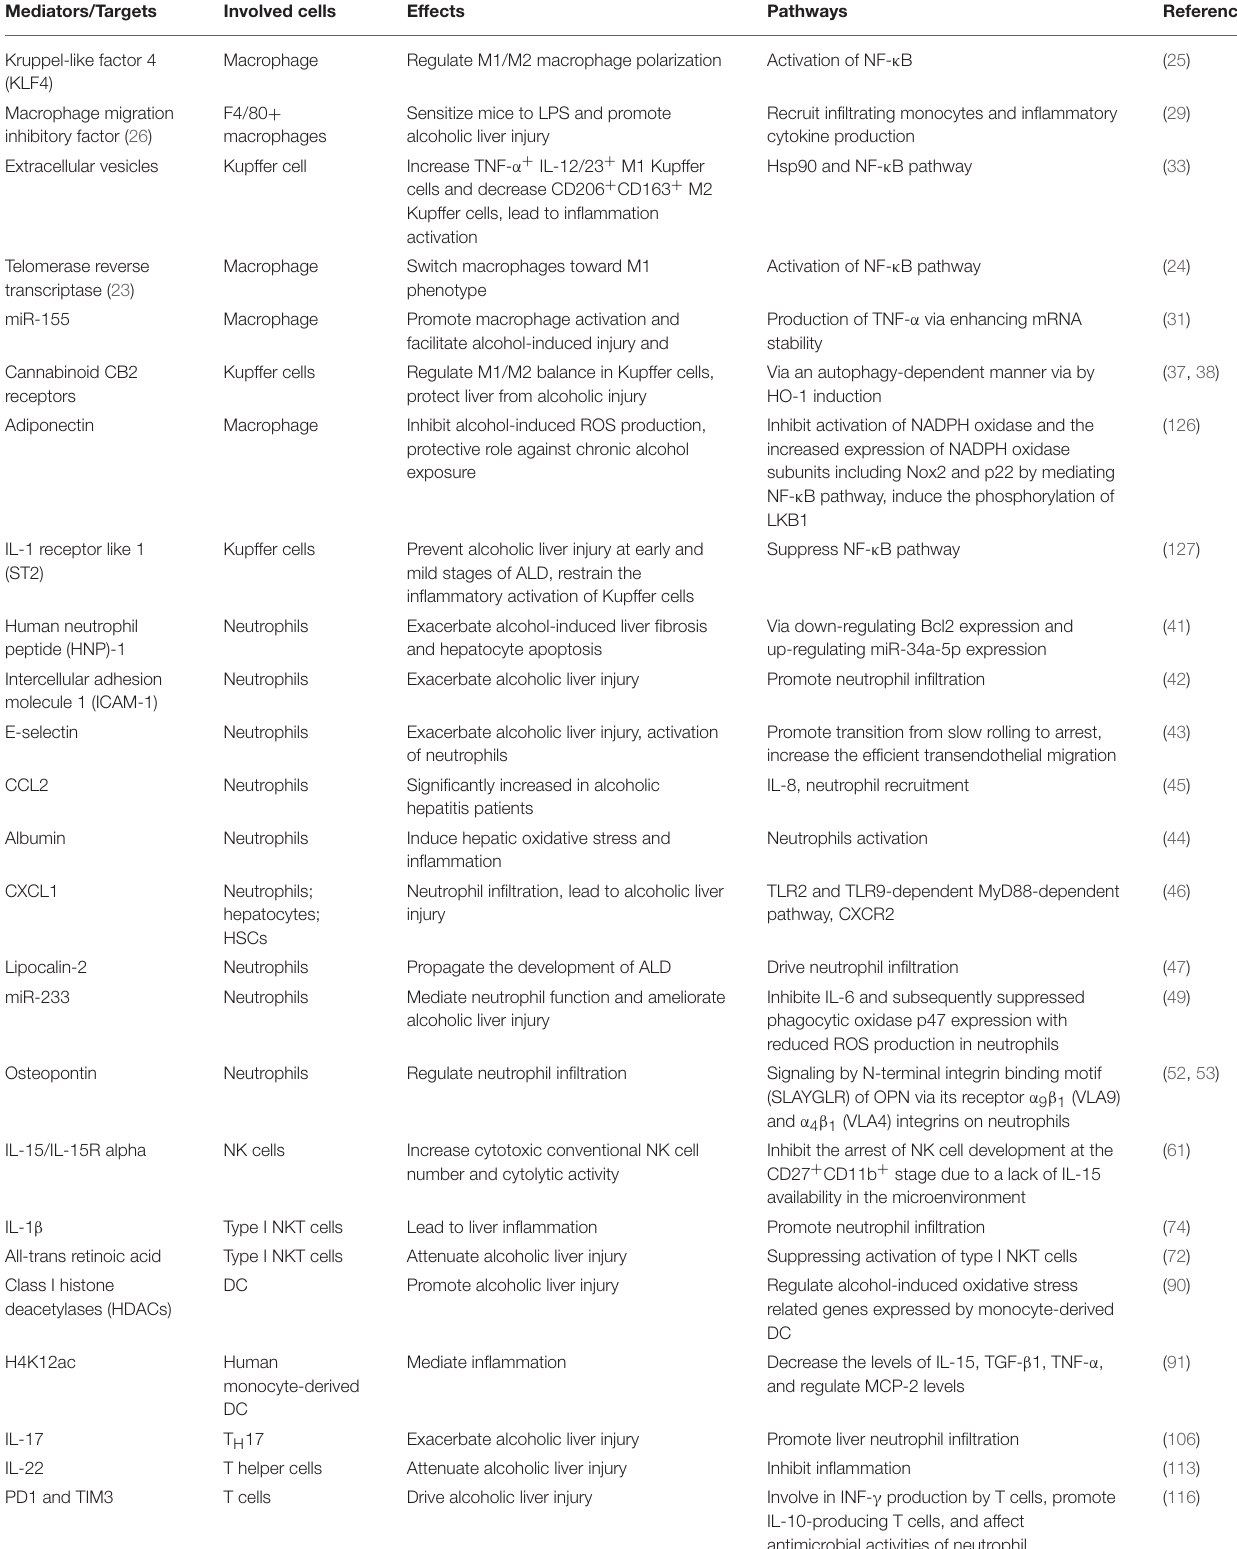
TABLE 1 | Emerging mediators involved in the response of several immune cells in